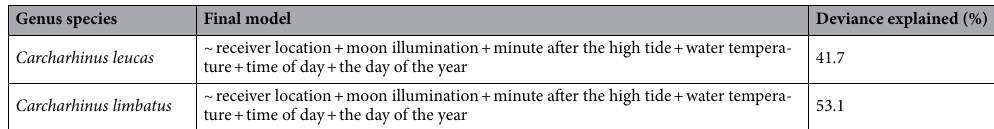
Table 3. The final model parameters included in, and the deviance of, the most accurate model of Carcharhinus limbatus and Carcharhinus leucas detection events when considering the effects of the measured environmental and spatiotemporal parameters (receiver location, moon illumination, minute after the high tide, tidal range, water temperature, time of day and the day of the year). The tidal range was removed from the models of both